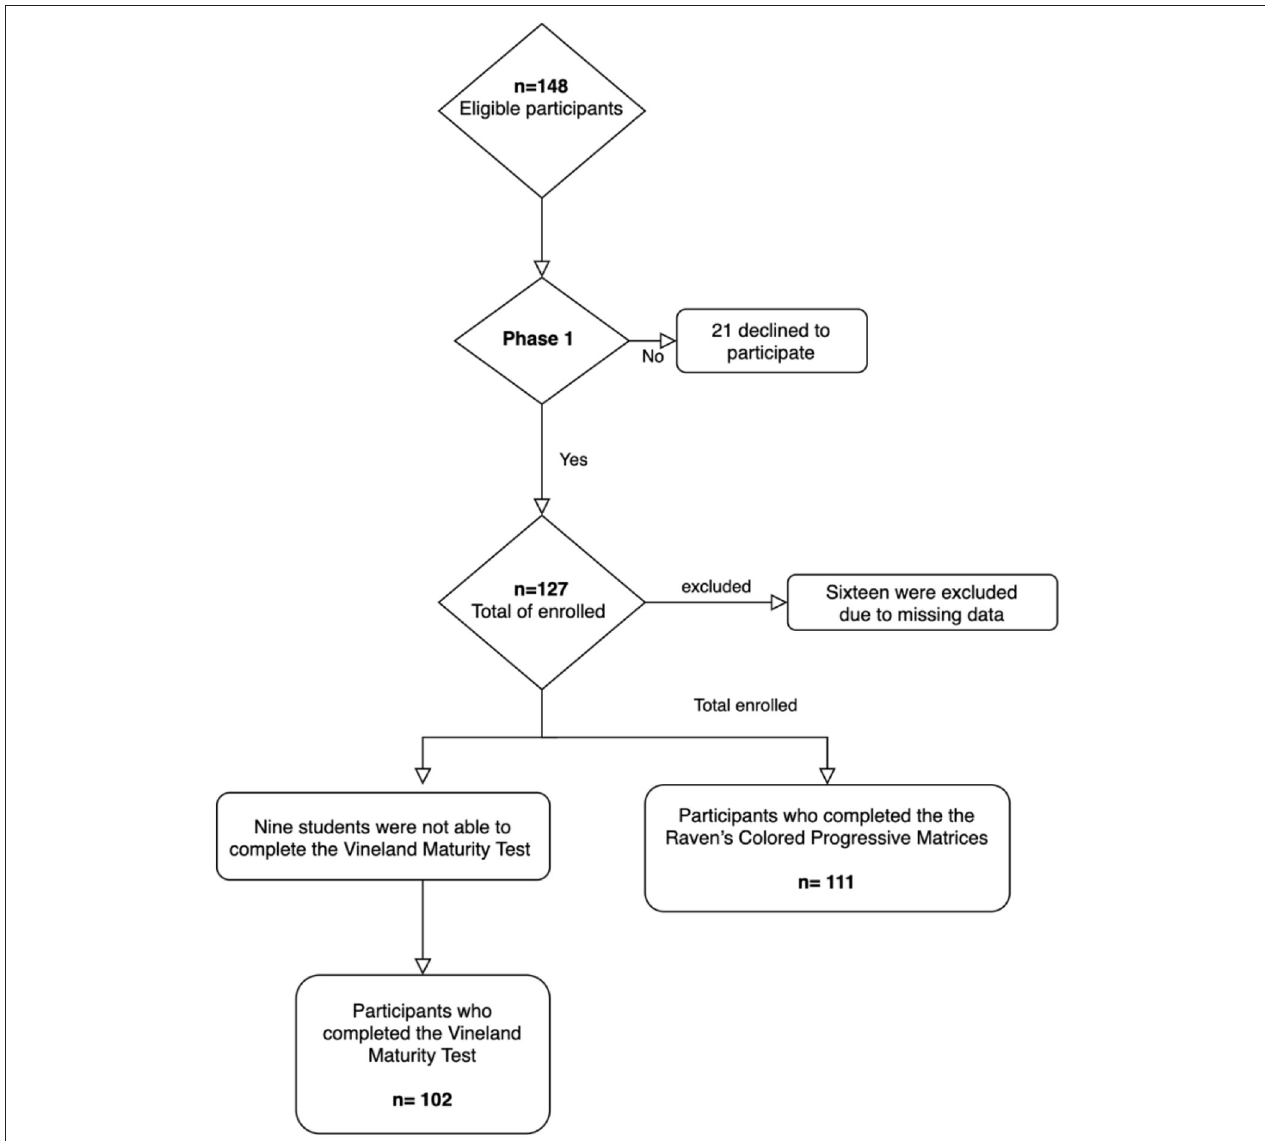
FIGURE 1 | Flowchart of participant